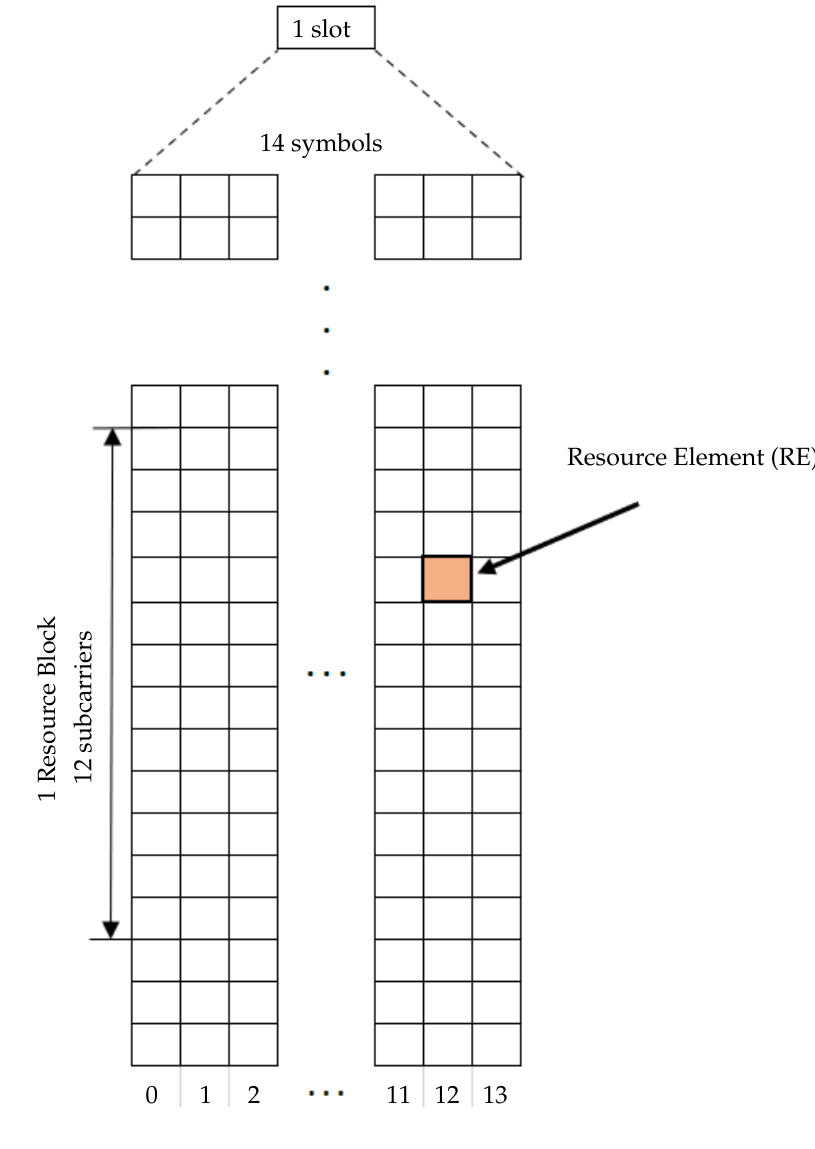
Figure 4. Resource grid